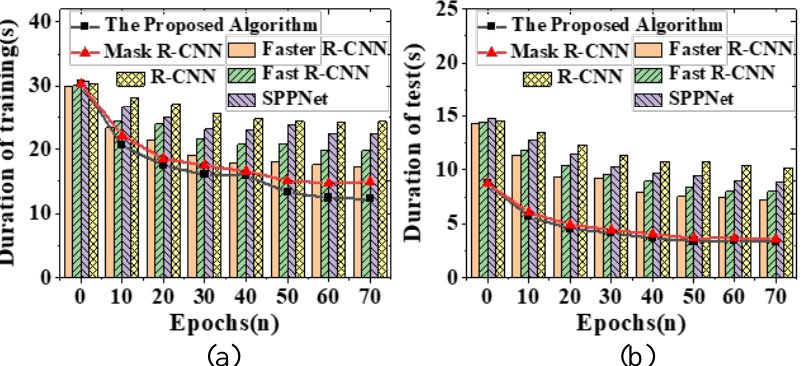
Figure 8. Comparison curves of the time required for phenotype recognition of various algorithms ( a ) training time; ( b ) testing time.